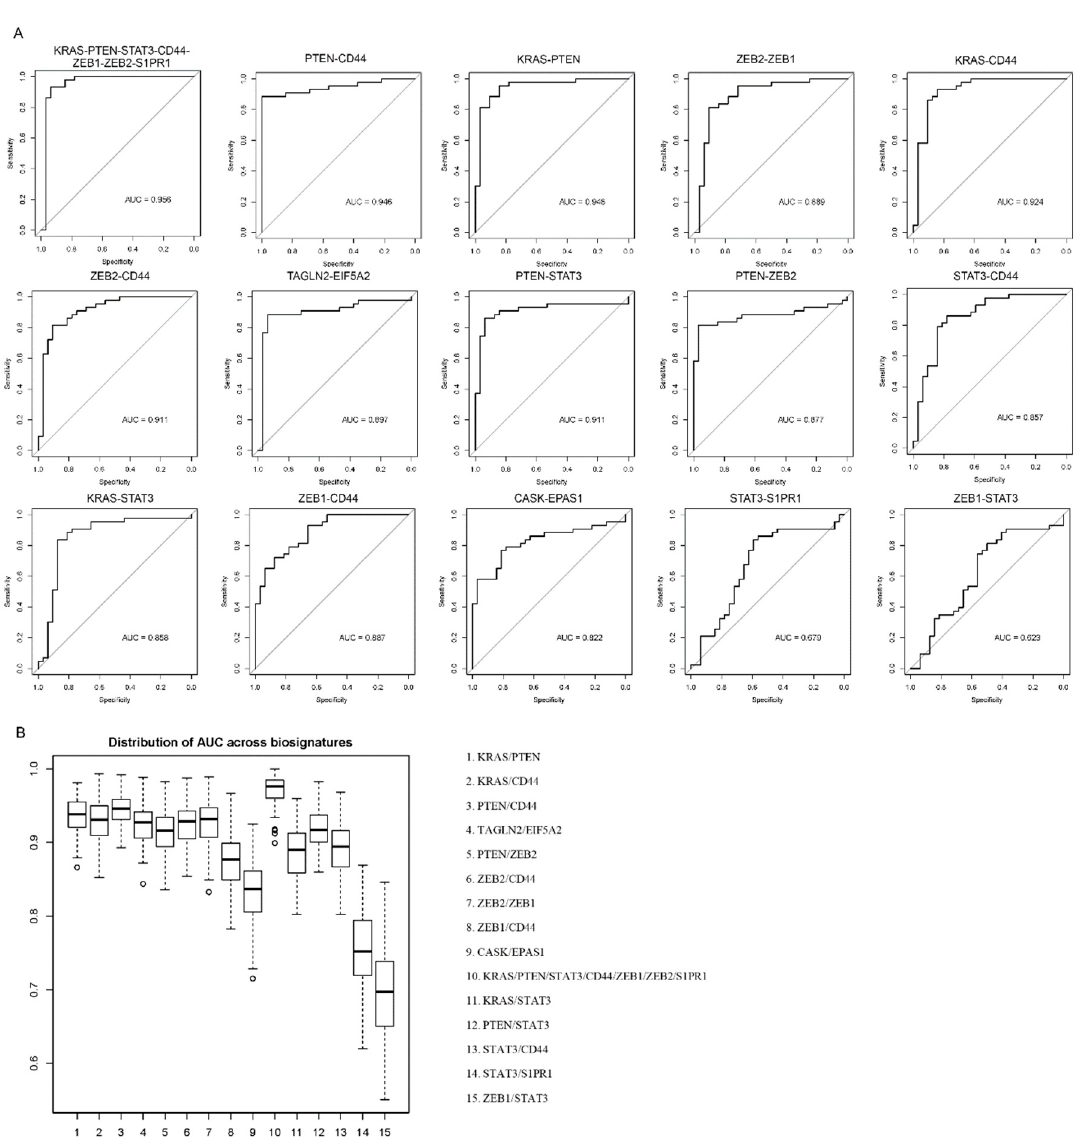
Figure 7. Diagnostic performance of multiple biomarkers for CRC. ( A ) The receiver operating (ROC) curves of all the 15 multiple biomarkers. ( B ) Distributions of AUC across biosignatures. The area under curve (AUC) statistics from 100 random training/testing divisions. The 15 multiple biomarkers were ranked.